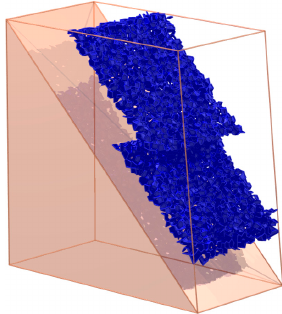
Figure 16. The bond is deleted to construct the parallel fracture in the example.